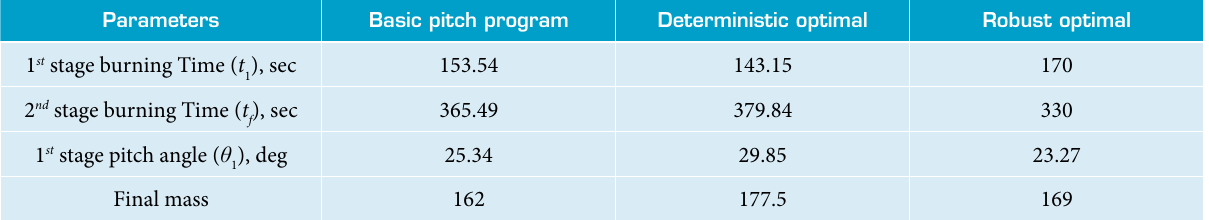
Table 3. The final parameters in the three modes, the non-optimal, optimal and the robust